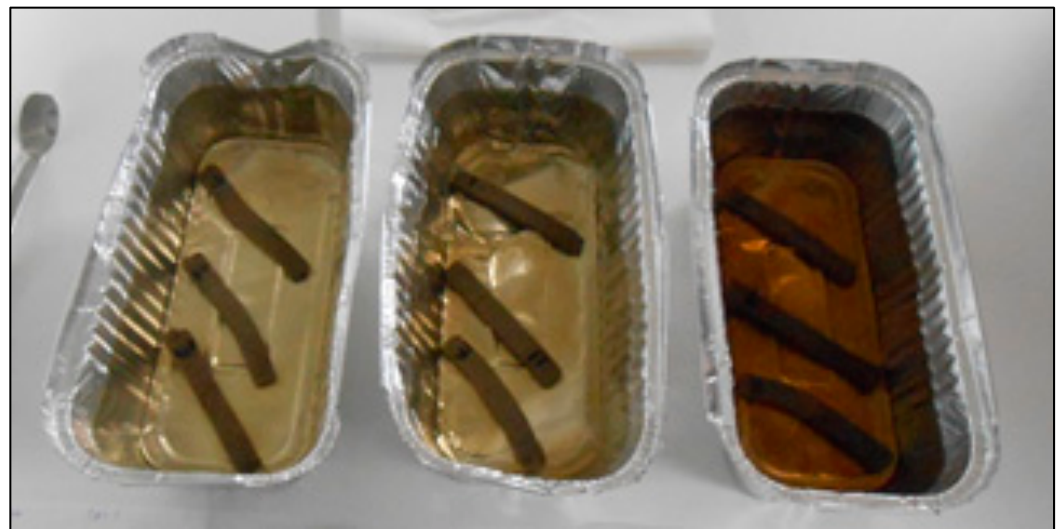
Figure 7. Macroscopical image illustrating the change of the visual of the SPC injection-molded piece-water system upon increasing the solid–liquid contact time (from left to right, 1, 3, and 6 h).